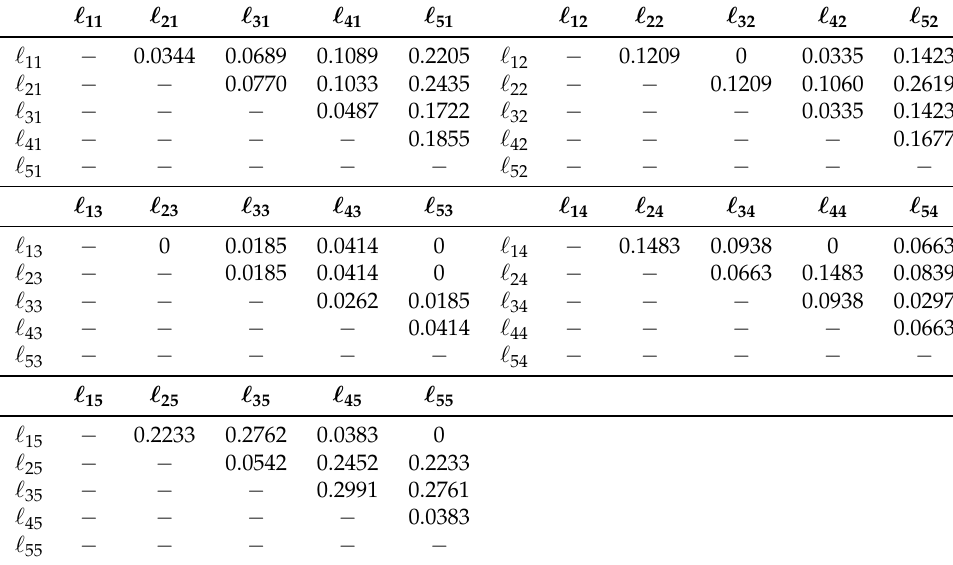
Table 6. Bipolar fuzzy weighted